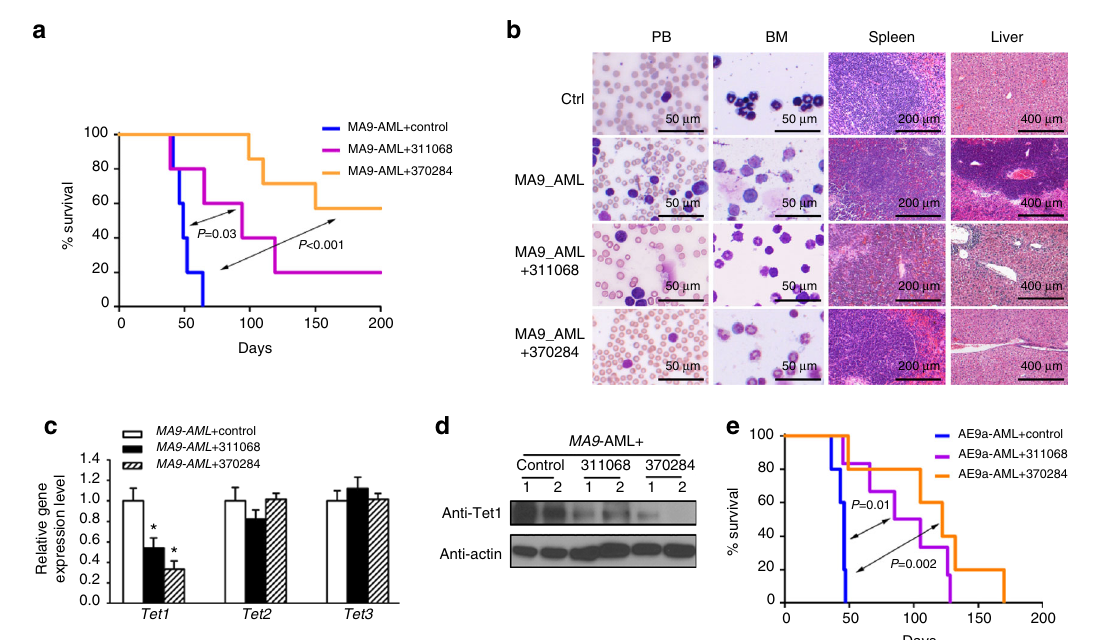
Fig. 2 Therapeutic effects of NSC-311068 and NSC-370284 in AML in vivo. a NSC-311068 or NSC-370284 administration inhibits MLL-AF9 -AML. The secondary BMT recipient mice were transplanted with leukemic BM blast cells collected from primary MLL-AF9 AML mice. Upon the onset of leukemia, the recipient mice were treated with DMSO (control; n = 5), 2.5 mg/kg NSC-311068 ( n = 5) or NSC-370284 ( n = 7), i.p., once per day, for 10 days. Kaplan – Meier curves are shown. The P values were determined by log-rank test. b Wright – Giemsa staining of mouse peripheral blood (PB) and BM, or hematoxylin and eosin (H&E) staining of mouse spleen and liver of the treated or control leukemic mice. c , d Tet1/2/3 gene expression levels ( c ), or Tet1 protein level ( d ), in BM blast cells of the treated or control leukemic mice. * P < 0.05, two-tailed t -test. Error bar indicates SD of triplicate experiments. e Effects of NSC-311068 and NSC-370284 on the AE9a -AML mouse model. The secondary BMT recipient mice were transplanted with leukemic BM blast cells collected from the primary AE9a- AML mice. Upon the onset of leukemia, the recipient mice were treated with DMSO (control; n = 5), 2.5 mg/kg